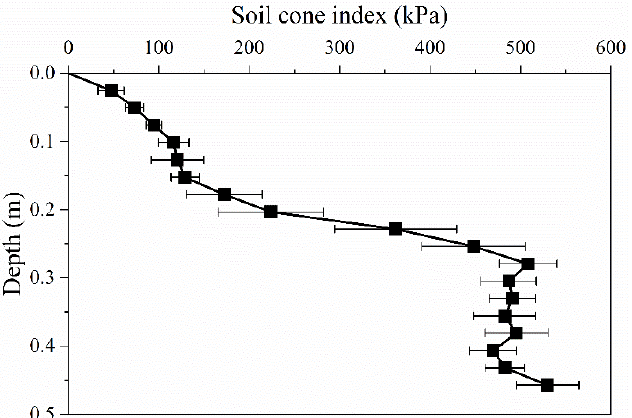
Figure 7. Soil cone index in field experiments.